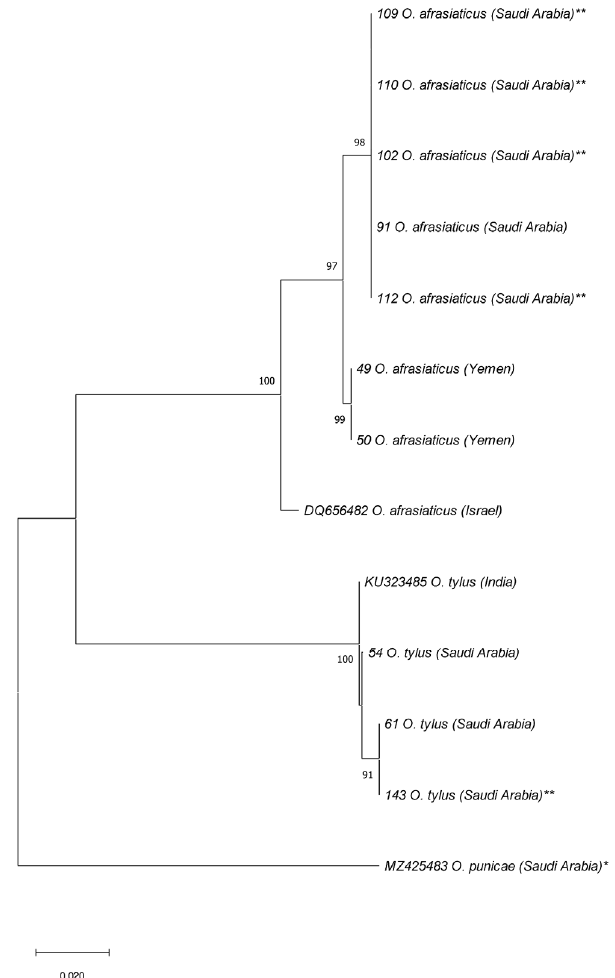
Figure 6. NJ phylogenetic tree based on 13 COI sequences, representing different populations of two closely related Oligonychus species ( O. afrasiaticus and O. tylus ) and one distantly related species, O. punicae (* was retrieved from GenBank and used as an outgroup taxon). A total of eight sequences were obtained in the present study from different hosts and regions in Saudi Arabia, and two from Yemen (** including samples that have not been identified morphologically till species due to the absence of males). The sequences of O. afrasiaticus from Israel and O. tylus from India were retrieved from GenBank. Numbers on tree branches are bootstrap values obtained from 1000 replicates.